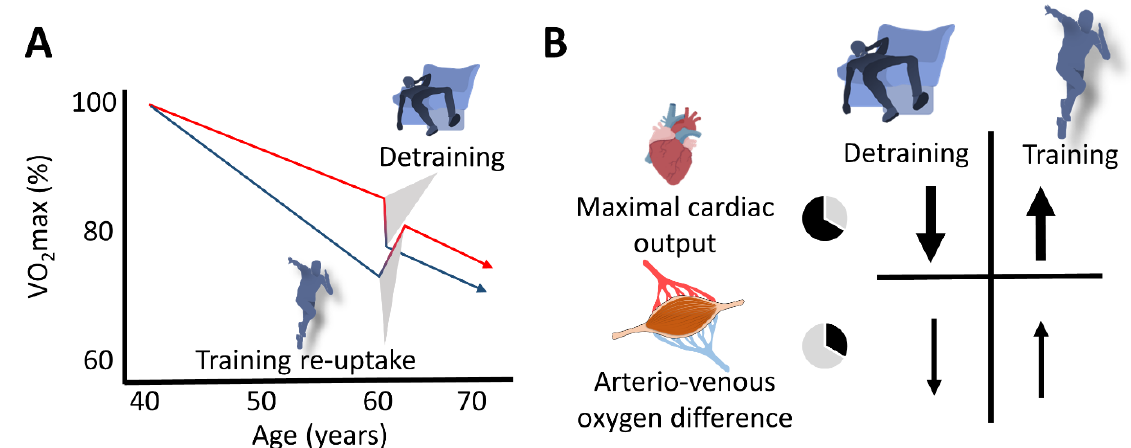
Figure 3. Schematic representation of the slow (aging) and the fast (changes in training habits) components of aging in masters endurance athletes. ( A ) The red line represents the aging-related decline in VO 2 max of continuously active endurance athletes, and the lower (blue) line represents that of masters athletes who terminated their competitive activities at the age of 40 years. Detraining rapidly enhances the rate of VO 2 max decline in active athletes, and recovery of VO 2 max can rapidly be achieved after (re)uptake of training. ( B ) Decline in maximal cardiac output represents the main explanatory mechanism for both the loss and restoration of VO 2 max.